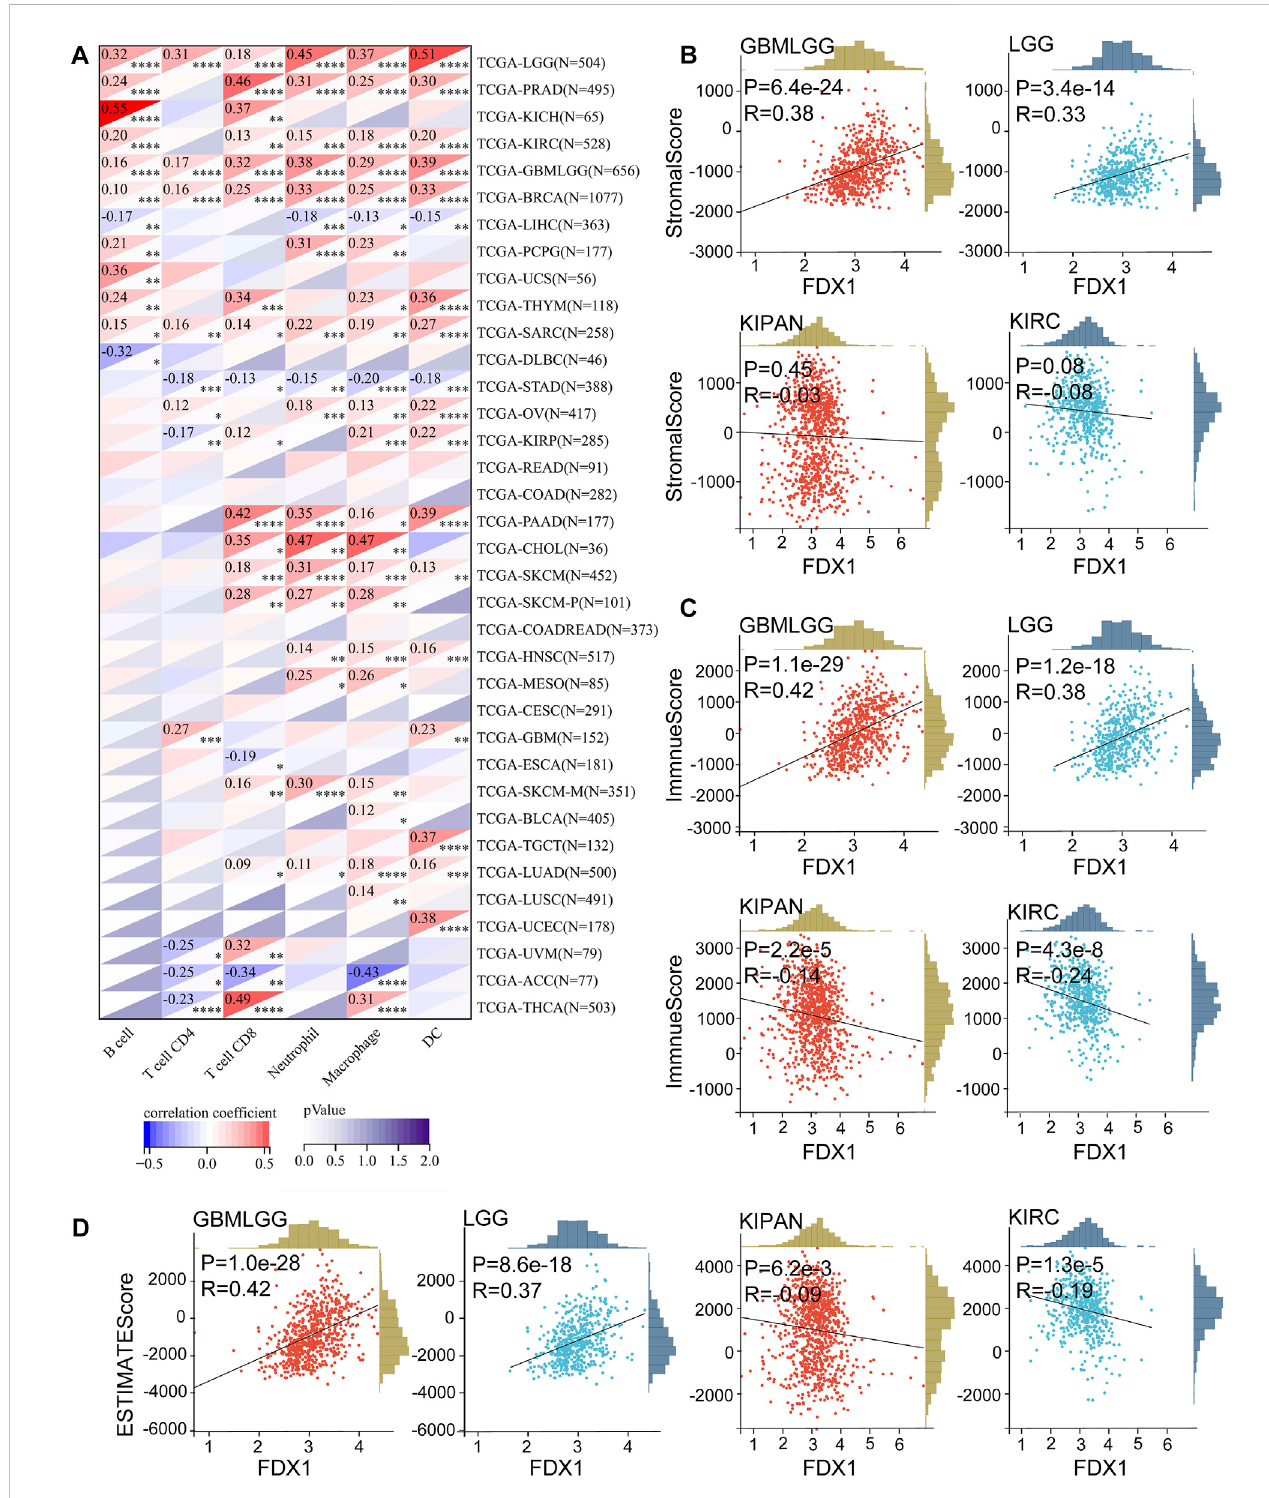
FIGURE 4 Correlation between FDX1 and immune cells in fi ltration in pan-cancer, StromalScore, ImmuneScore, ESTIMATEScore in LGGGBM, LGG, KIPAN, and KIRC. (A) The FDX1 expression was associated with B cell, CD4 + T cell, CD8 + T cell, neutrophil, macrophage, and dendritic cell (DC) based on the TIMER algorithm. (B) The FDX1 expression was associated with StromalScore in LGGGBM, LGG, KIPAN, and KIRC. (C) The FDX1 expression was associated with ImmuneScoreinLGGGBM,LGG,KIPAN,andKIRC. (D) TheFDX1expressionwasassociatedwithESTIMATEScoreinLGGGBM,LGG,KIPAN,andKIRC.( p < 0.05 was considered signi fi cant, all correlation analysis was shown by Pearson coef fi